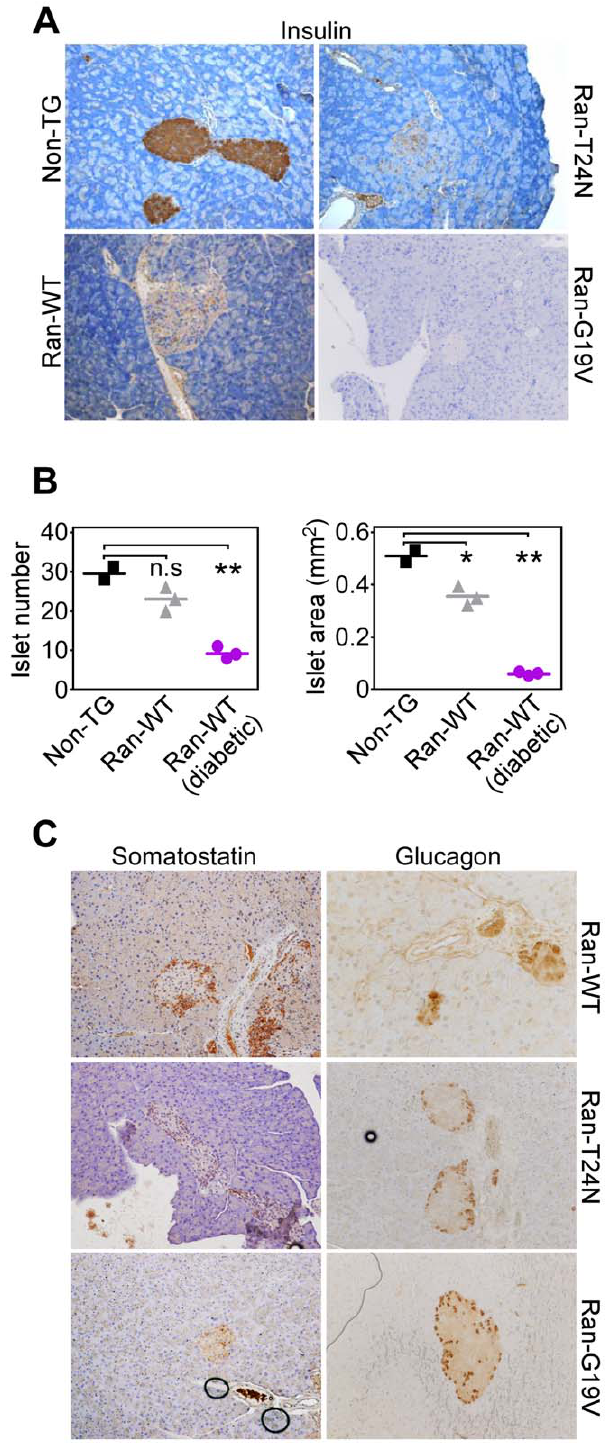
Figure 4. Defective islet development in Ran transgenic mice. A , Pancreas tissues from non-TG, Ran-WT, Ran-G19V or Ran-T24N transgenic mice were analyzed by H&E or immunohistochemical staining with an antibody to insulin. B , Pancreas sections from non- TG, asymptomatic Ran-WT or diabetic Ran-WT transgenic mice were analyzed for islet number or islet surface area by morphometry of insulin-stained areas. Islet number, non-TG (n=2), 29.5 6 1.5; Ran-WT (n=3), 23 6 1.73, n.s., not significant; Ran-WT diabetic (n=3), 9.33 6 0.88, **, p=0.001; islet surface area, non-TG (n=2), 0.51 6 0.02;